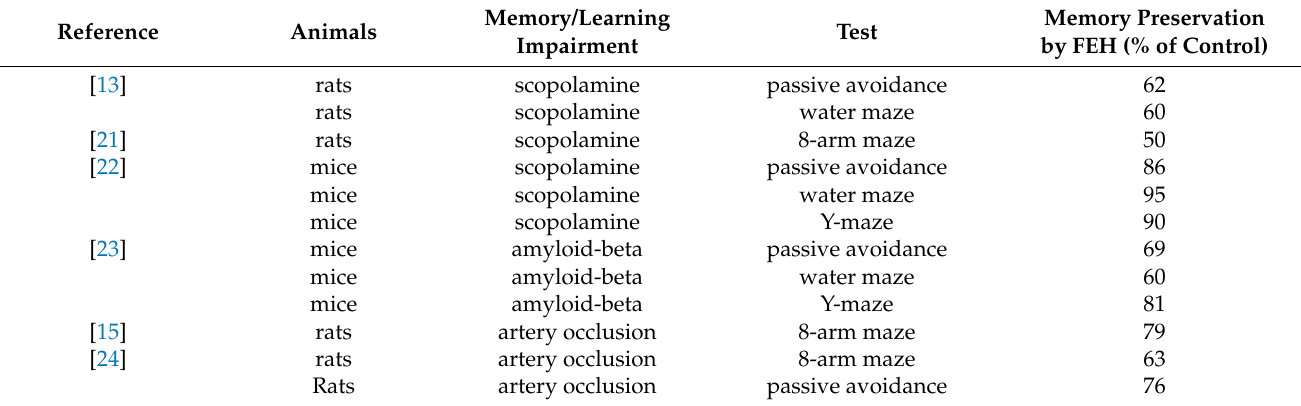
Table 2. Silk Fibroin Enzyme Hydrolysate Animal